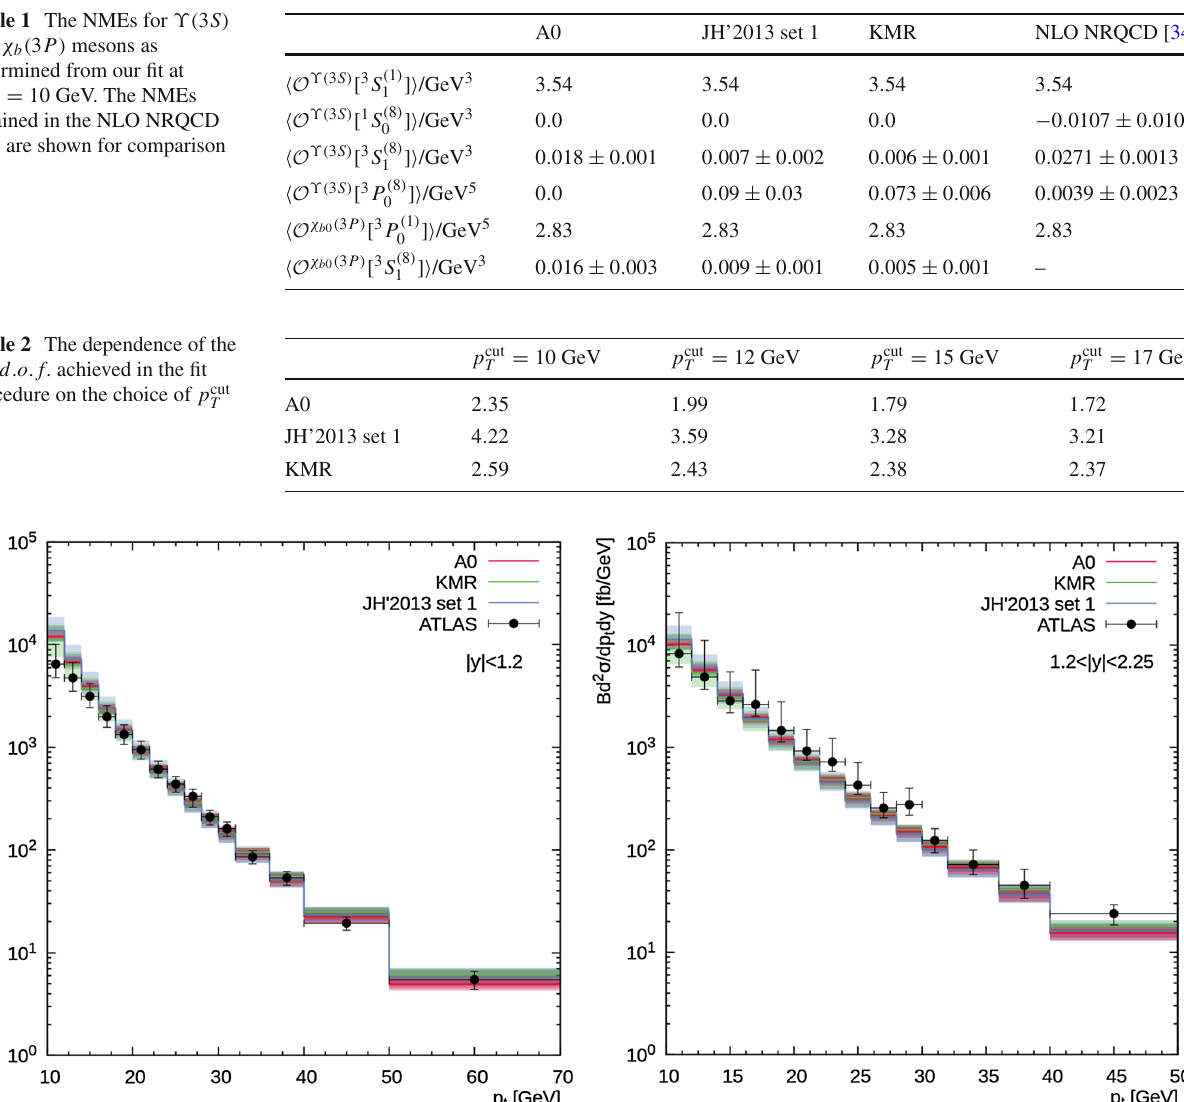
Fig. 3 Transverse momentum distribution of inclusive ϒ( 3 S ) produc- √ s = 7 TeV in the different rapidity regions. The red, tion calculated at green and blue histograms correspond to the predictions obtained with